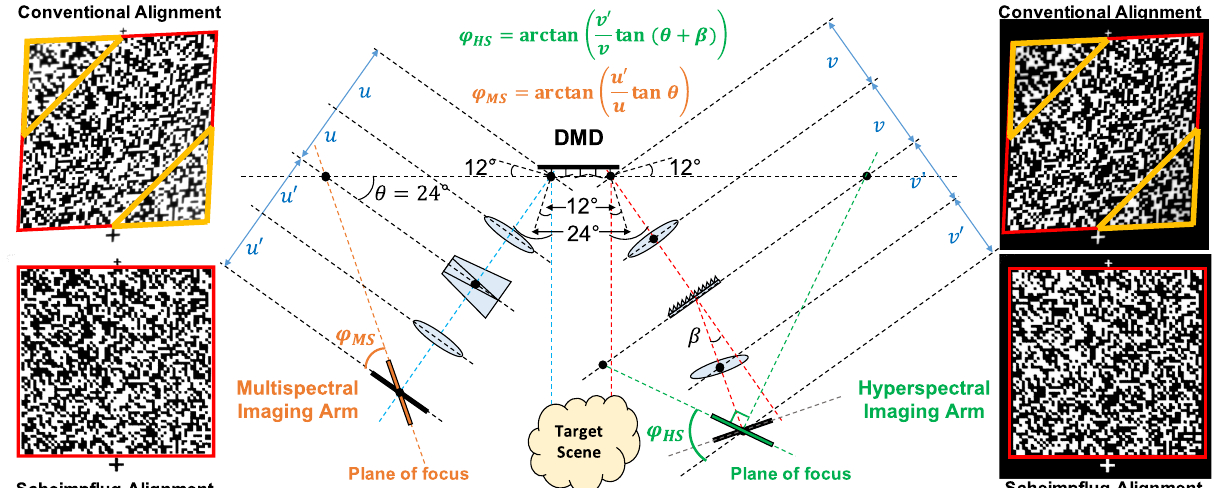
◦ Figure 2. Scheimpflug alignment. Given the ± 12 inclination of the DMD micro-mirrors, light perpendicularly ◦ impinging the DMD reflects at ± 24 . This causes non-uniform focus (within the yellow triangles, in the conventional alignment insets) and distortion of the image in the sensor (inclination), due to the different optical path lengths. To correct this, the sensors must be rotated along the horizontal axis by the Scheimpflug angles ϕ MS and ϕ HS , respectively. The latter depends on the angle ( β ) of the first diffraction order. Note that the images in both sensors are complementary to each